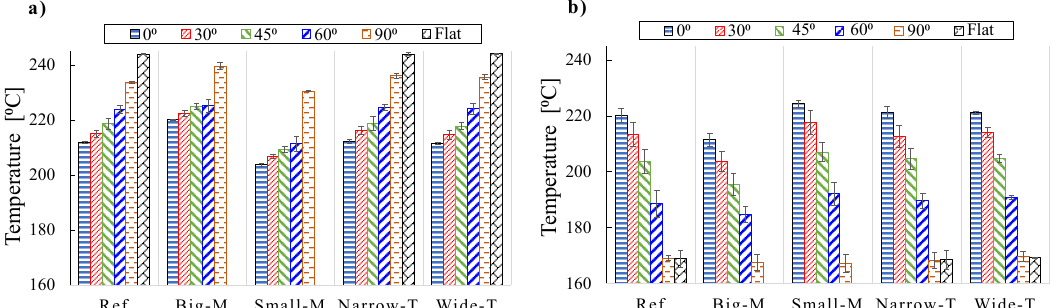
Figure 17. Average temperatures of ( a ) tape and ( b ) substrate and corresponding standard deviations at the nip line for each simulation case as a function of selected θ